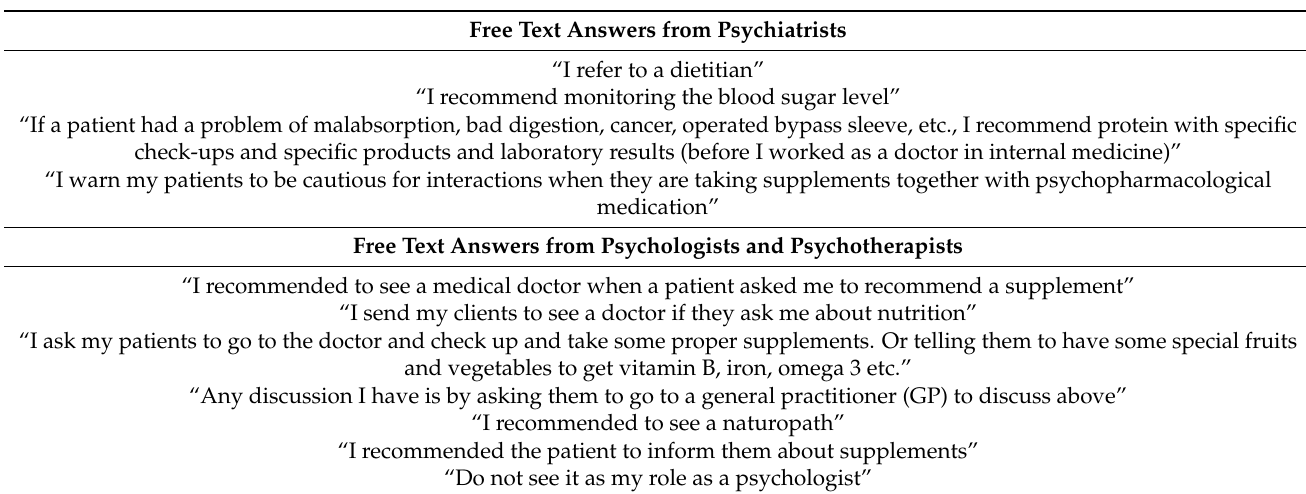
Table 6. List of additional comments by survey participants when asked about supplements in psychiatric and psychological